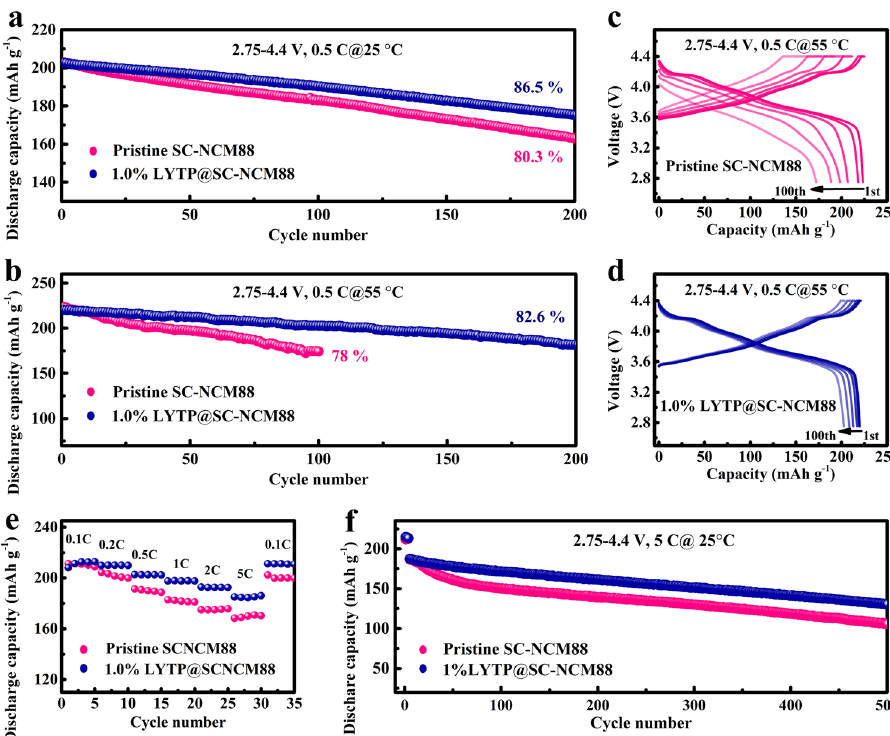
Fig. 4 Electrochemical characterization of coin-type half cells. Cycling stability of pristine SC-NCM88 and 1% LYTP@SC-NCM88 against a lithium metal anode at 0.5 C under testing temperature of ( a ) 25 °C and ( b ) 55 °C. Charge/discharge curves for ( c ) SC-NCM88 and ( d ) 1% LYTP@SC-NCM88 from 1st to 100th cycle at 55 °C. e Cycling capability at various current densities and ( f ) long-term cycling stability at 5 C for SC-NCM88 and 1% LYTP@SC- NCM88. All cells were cycled in the voltage range 2.75 – Fig. 4a, the 1% LYTP@SC-NCM88 achieves a reversible capacity